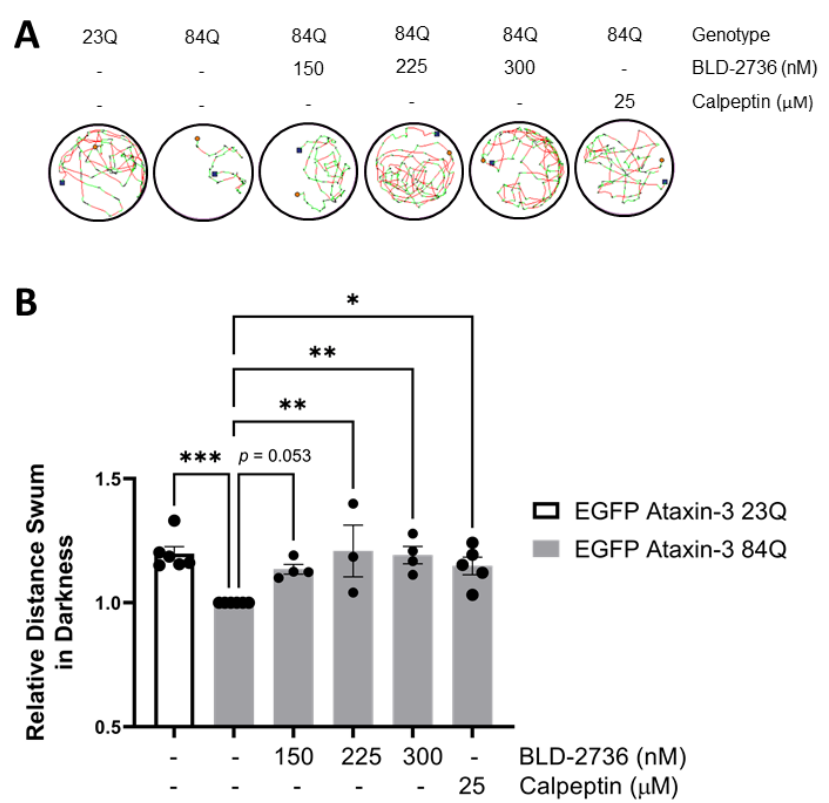
Figure 1. Treatment with BLD-2736 from 1 to 6 days post-fertilization improves SCA3 zebrafish swimming performance. ( A ) Representative trajectories displaying the distance swum during motor performance assays at 6 days post-fertilization. ( B ) Transgenic zebrafish expressing EGFP-fused human ataxin-3 with 84 polyglutamines swim shorter distances than zebrafish expressing EGFP-fused human ataxin-3 with 23 polyglutamines. Treatment with calpain inhibitors (BLD-2736 or calpeptin) improved the distance swum. All data are presented as mean ± SEM, n = 12–24 larvae were examined per group. * represents p < 0.05, ** represents p < 0.01, *** represents p < 0.001.